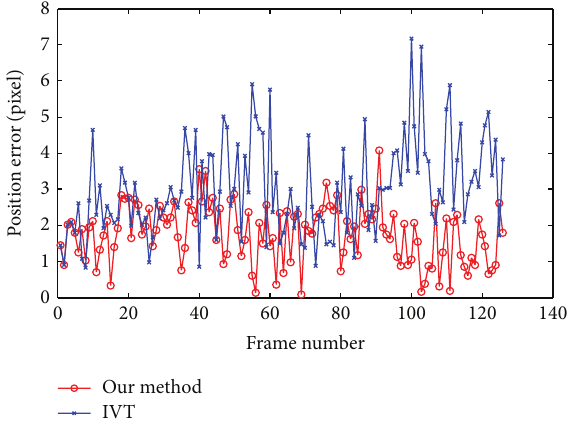
Figure 4: Position error for seq.1. Figure 5: RSF for each cue throughout